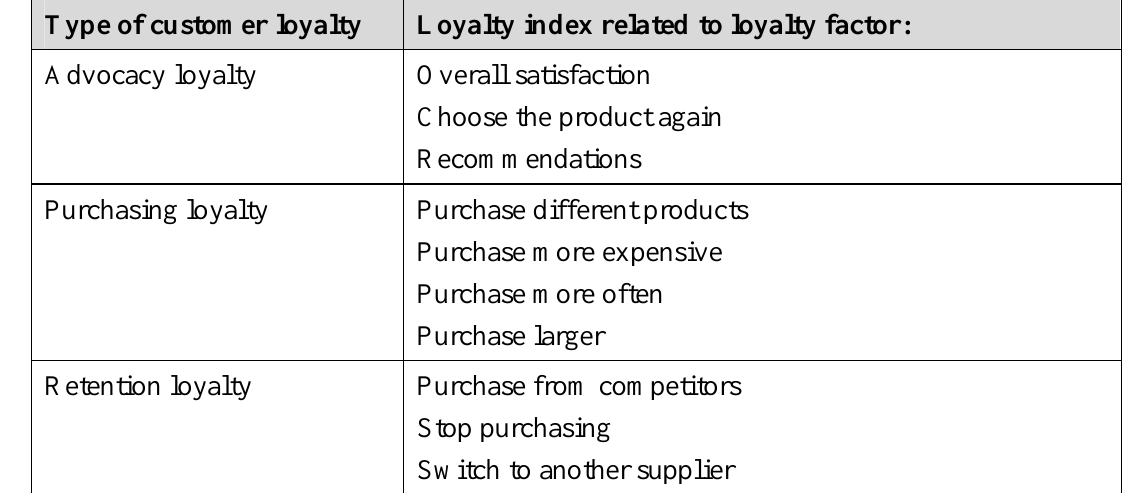
Table 3 – Customer loyalty: behaviour proposed for measuring (own research). Type of customer loyalty Loyalty index related to loyalty